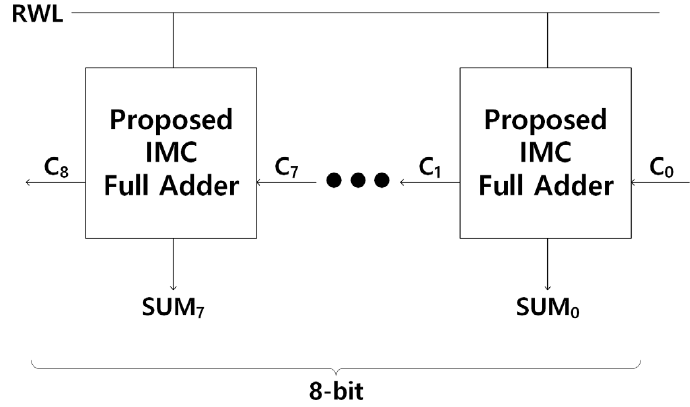
Figure 5. Diagram of the proposed 8-bit IMC Ripple Carry Adder. Table 4. Comparison of the performance and energy consumption in different 8-bit Ripple Carry